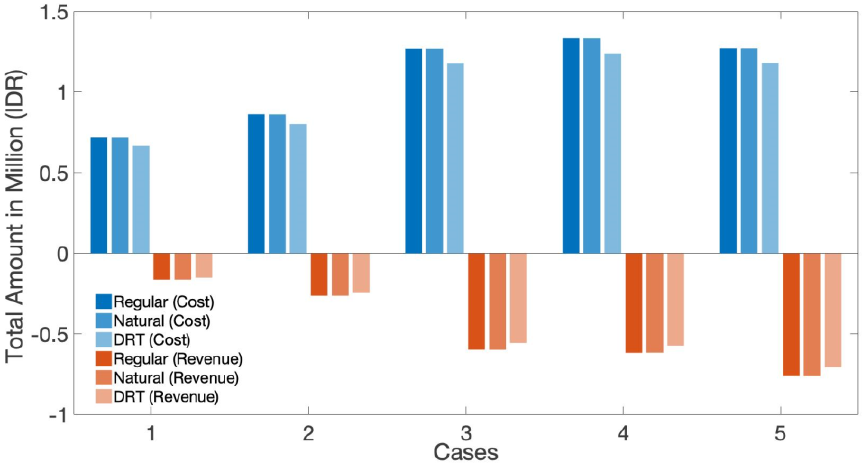
Figure 9. Cost and revenue during V2G participation.